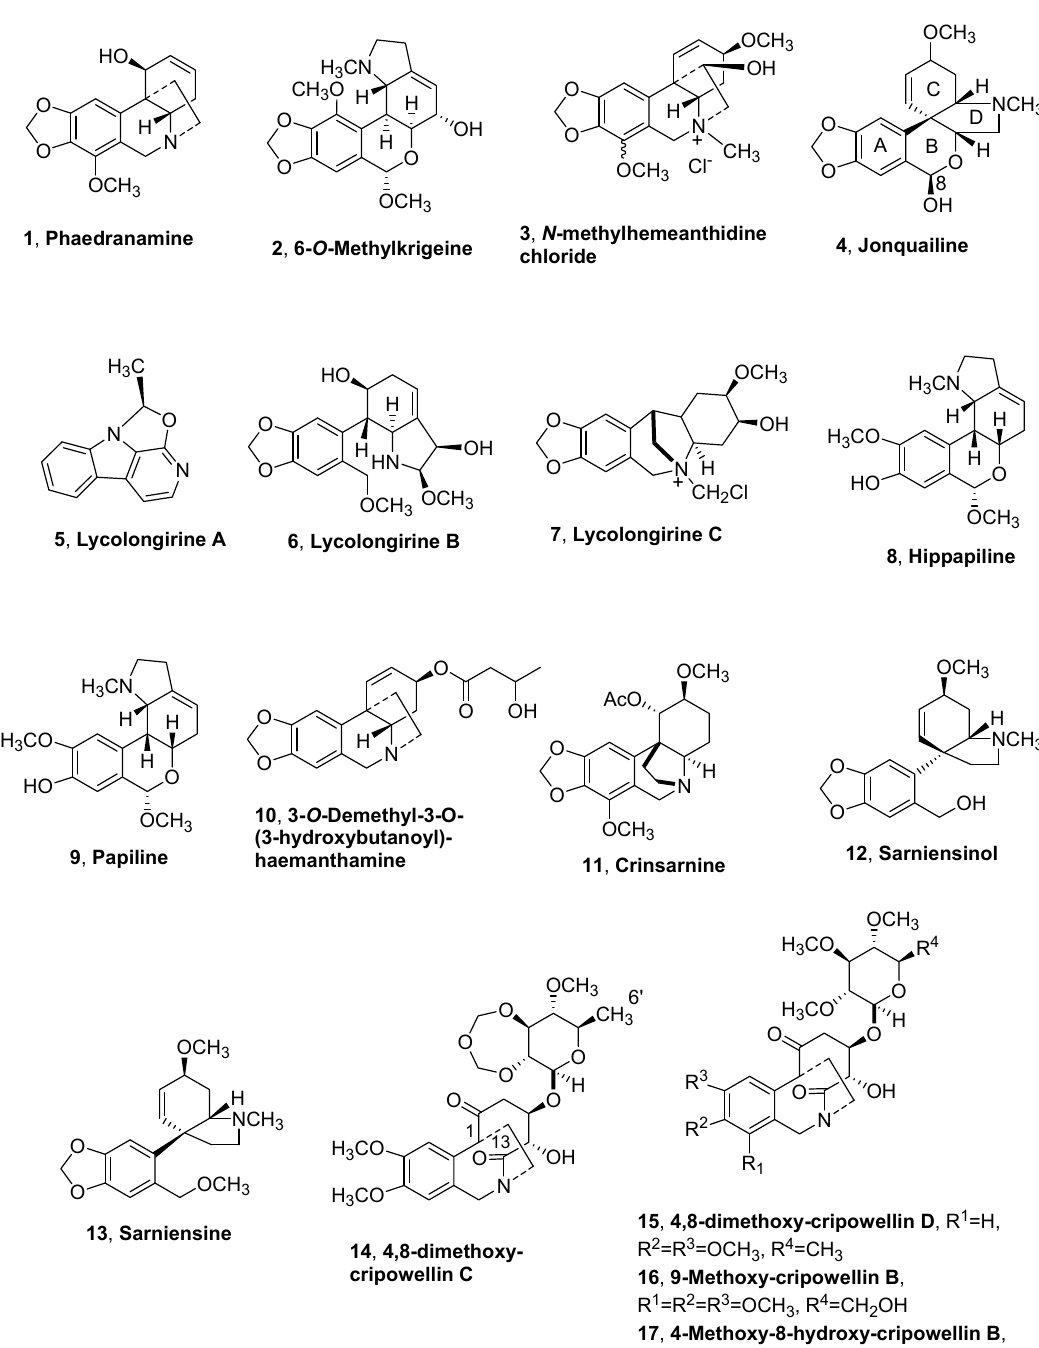
Figure 1. Alkaloids and natural analogues isolated from Phaedranassa dubia , Nerine huttoniae , Zephyranthes candida , Narcissus jonquilla quail , Lycoris longituba , Hippeastrum papilio , Nerine sarniensis , and Crinum latifolium .